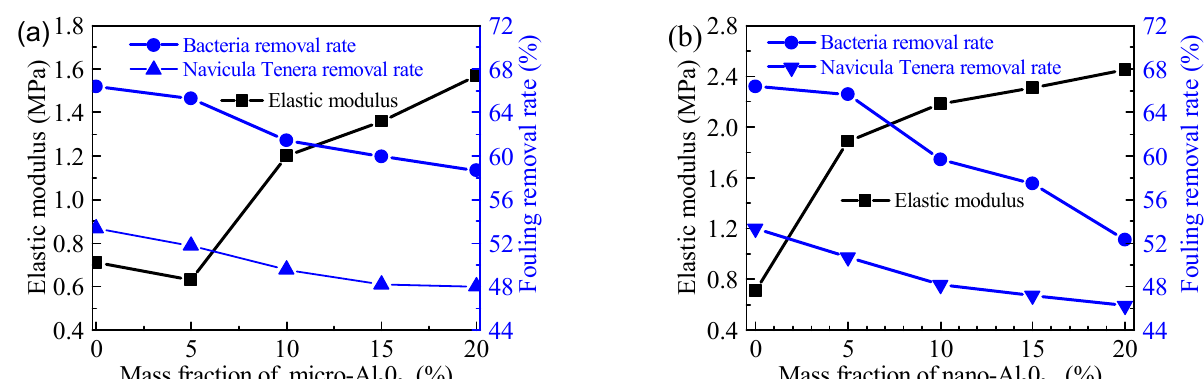
Figure 10. Elastic modulus and fouling removal rate of studied coatings: ( a ) Micro-alumina, ( b ) Nano-alumina.